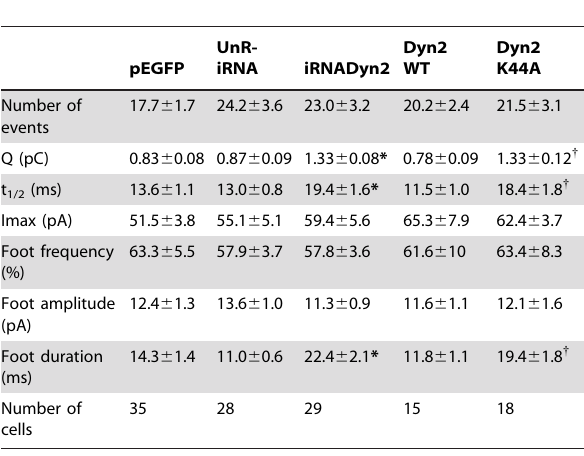
Data are means 6 SEM of averages, where n is the number of cells. Imax corresponds to the spike amplitude. *p , 0.05 compared with pEGFP-transfected cells; { p , 0.05 compared with Dyn2 WT-transfected cells (Kruskal-Wallis test).